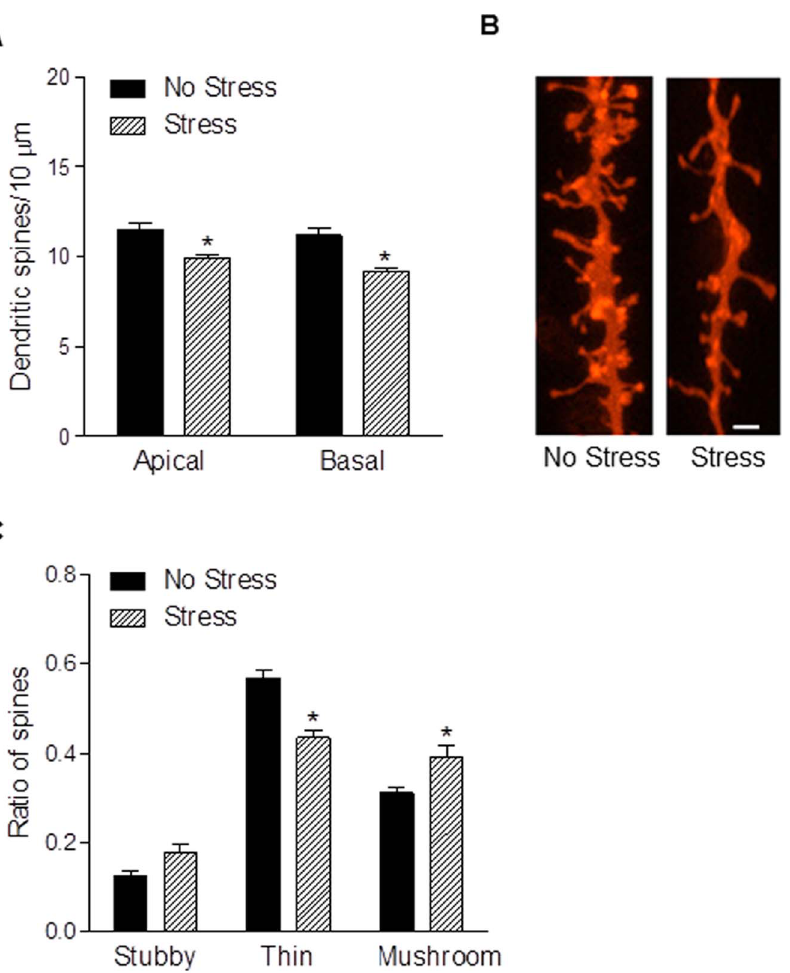
Figure 5. Chronic gestational reduces mPFC dendritic spine density and alters spine morphology. Postpartum females subjected to chronic gestational stress had fewer dendritic spines on apical and basal dendrites of layer 2/3 pyramidal neurons in the mPFC (a). Representative DiI labeled dendritic segments, scale bar=1 m m (b). Exposure to chronic gestational stress also caused a shift in spine morphology such that there was a decrease in the proportion of thin spines but an increase in the proportion of mushroom spines in stressed mothers (c). Bars represent mean 6 SEM, * p , 0.05.